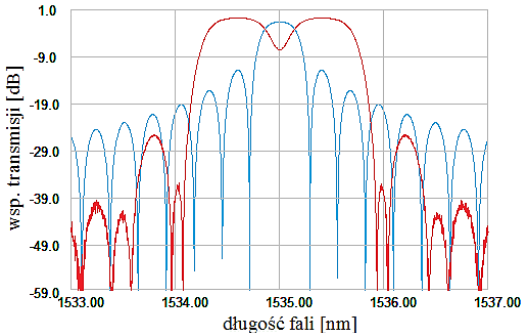
Fig. 16. Comparison of Bragg fiber gratings spectral characteristics without apodization – blue line and apodized Blackman function wsp. a =5 – red line.